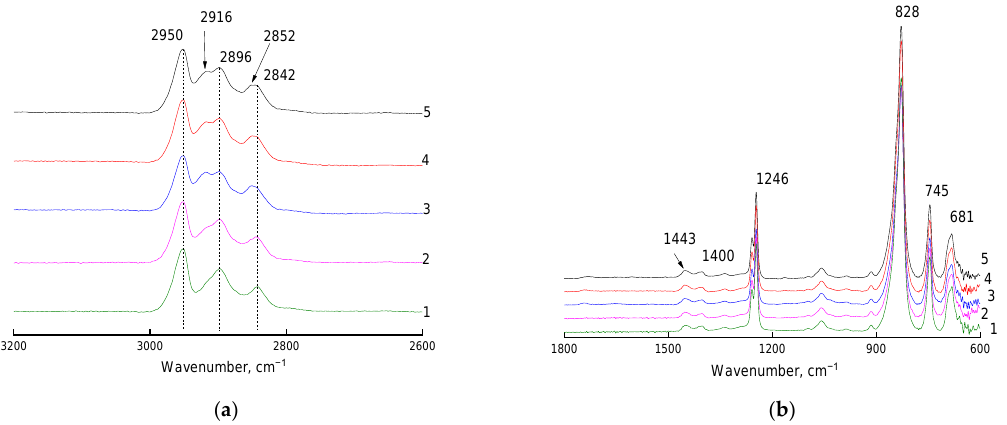
Figure 3. Fragments (( a ): 2600–3200 cm − 1 region; ( b ): 600–1800 cm − 1 region) of ATR-IR spectra (Ge crystal) of the PVTMS film recorded on the side opposite to the flow of the fluorinating agent. Curve 1: original film; curves 2–5: films fluorinated for 15, 30, 45, and 60 min, respectively.